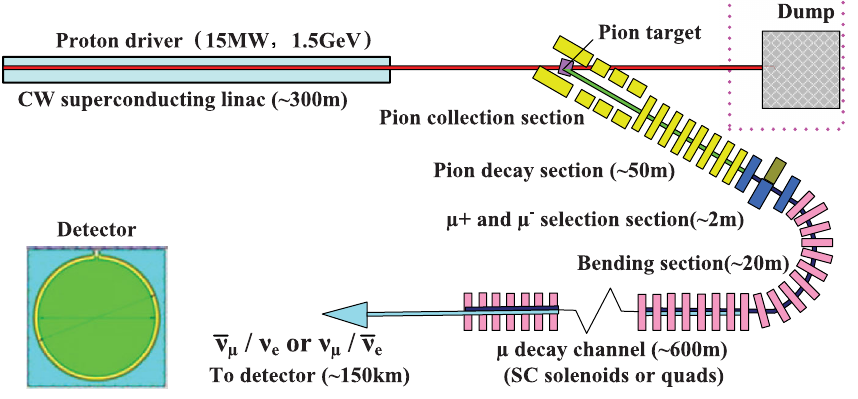
FIG. 2. Schematic layout of the MOMENT facility.